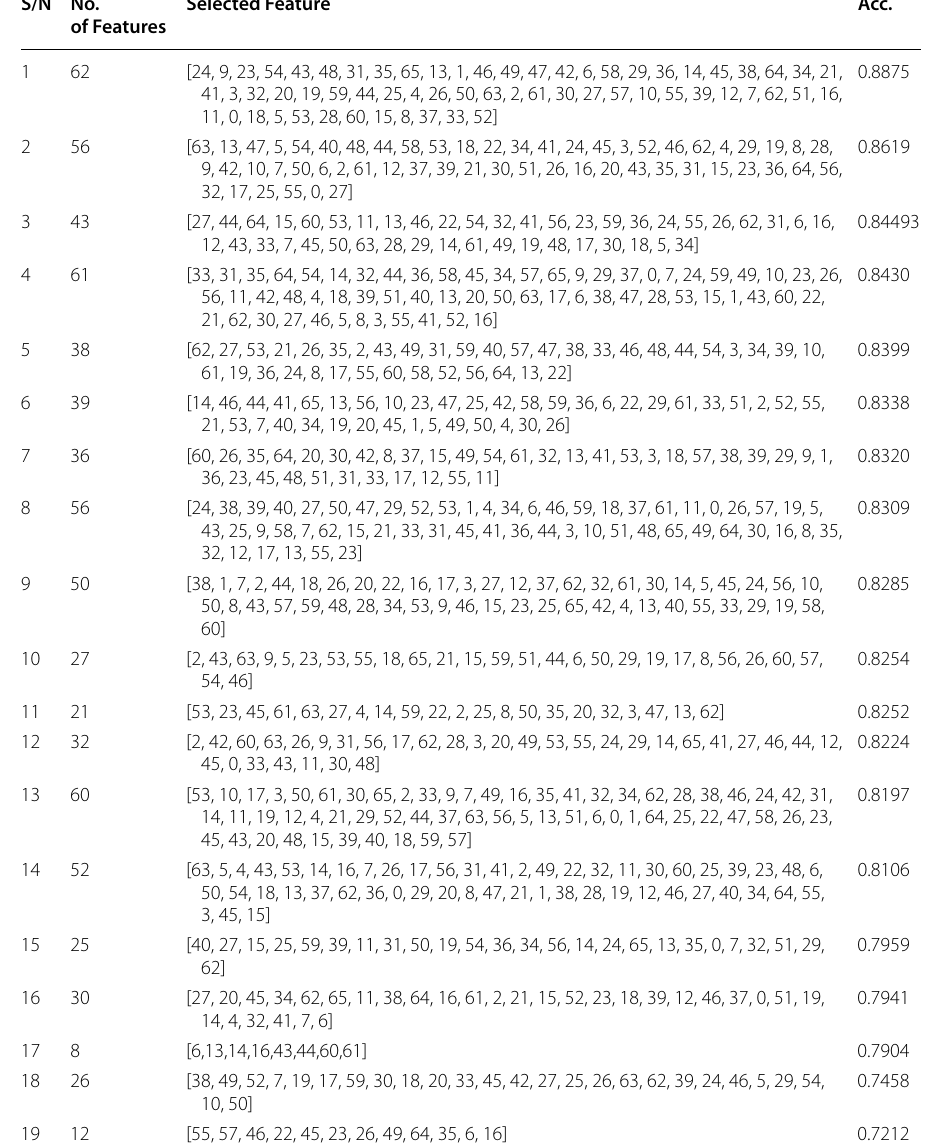
Table 7 CNN output for twenty different randomly selected features S/N No. Selected Feature of Features